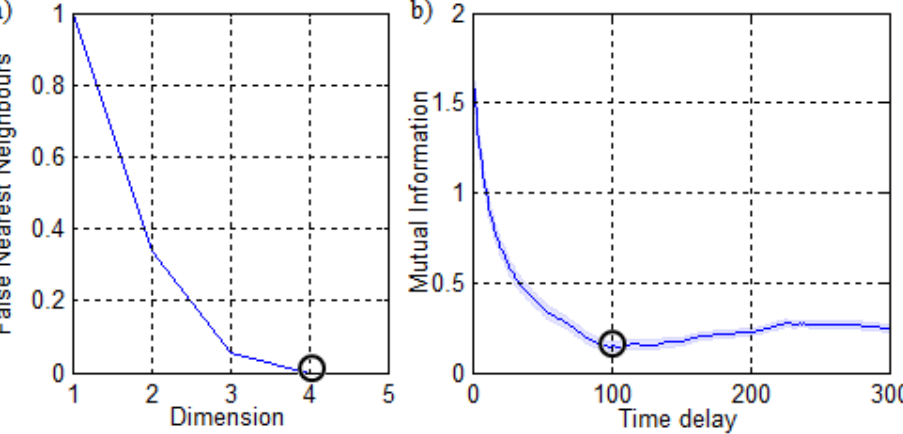
Figure 3. Estimation of τ and m for pressure fluctuations in the period of time between 101–106 s (Figure 2): ( a ) false nearest neighbors as a function of the embedding dimension; ( b ) mutual information as a function of time delay. The calculations have been made using the CRP toolbox for Matlab ® [27].